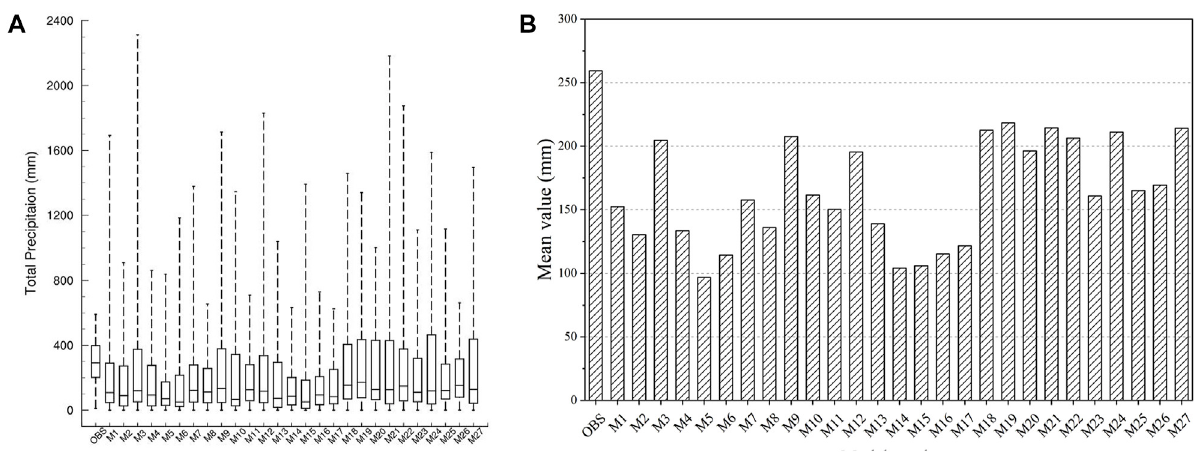
FIGURE 3 TCP of observation and WRF simulations. (A) Range of TCP for simulation and observation. Thick horizontal lines in boxes indicate the median values, and boxes show the inner-quartile (25% – 75%). (B) Mean values of the